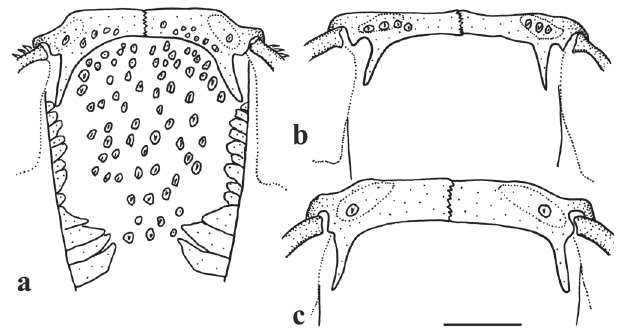
Fig. 2. Abdominal plates of Pareiorhaphis . (a) P . scutula , MCP 37182; (b) P . nasuta , MCP 37176; and (c) P . parmula , MCP 29434. Scale bar = 5 mm.